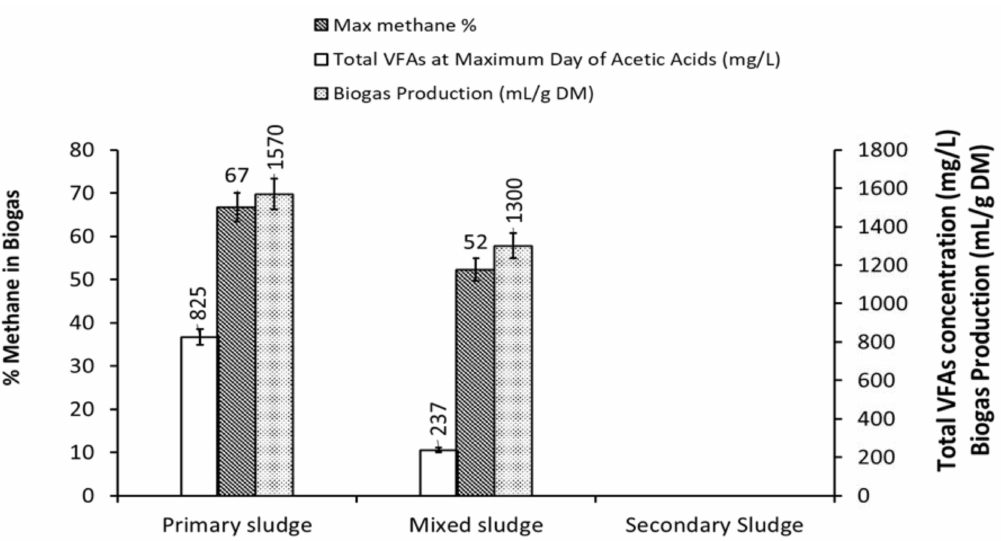
Figure 5. The maximum total VFAs with the maximum biogas production rate (mL/g